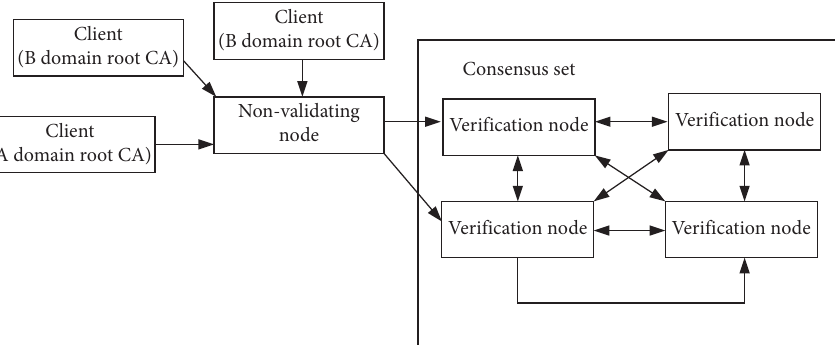
Figure 4: Topological structure of blockchain platform